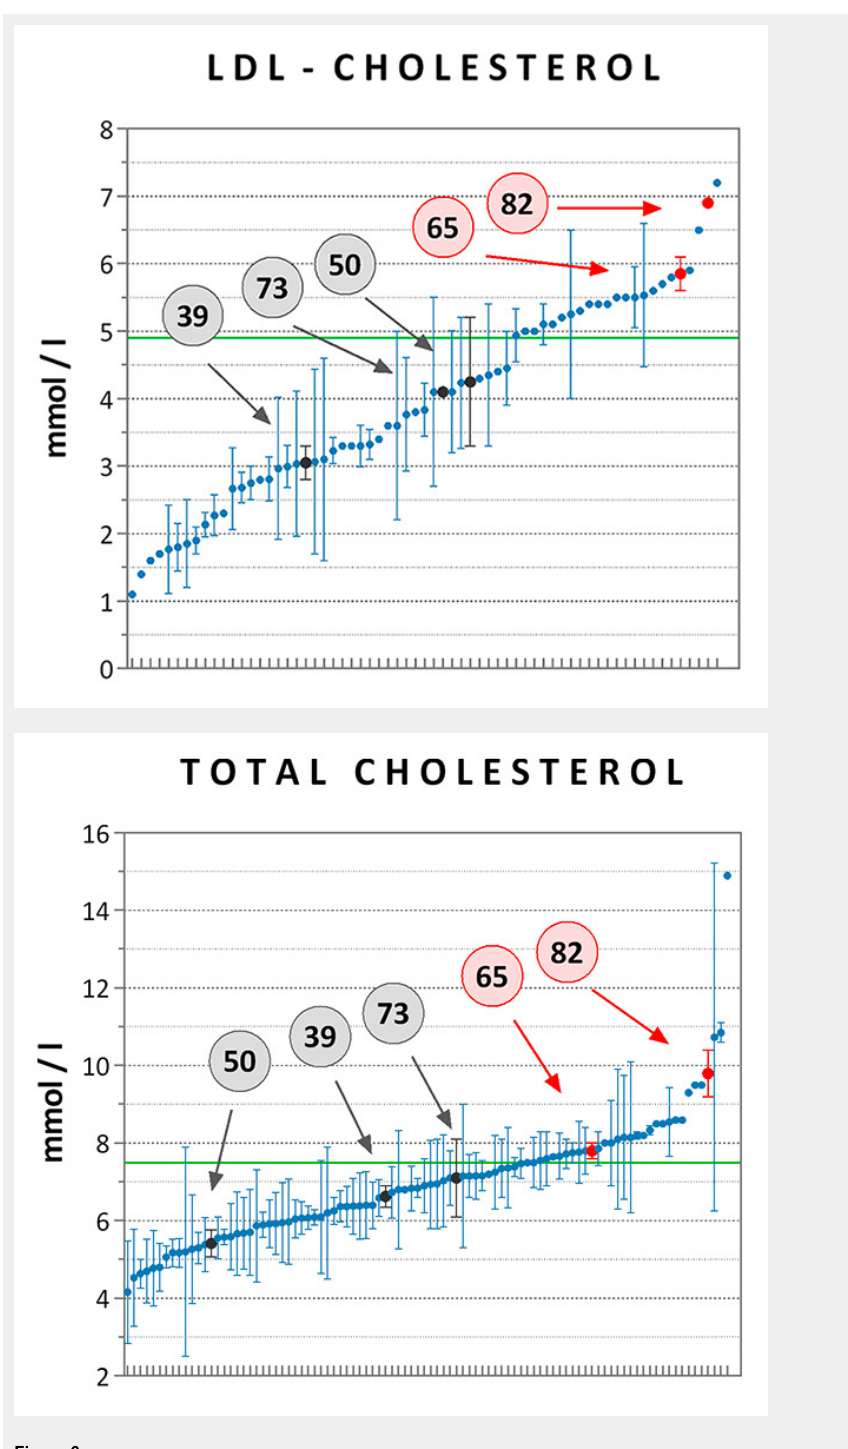
Figure 6 Cholesterol levels measured in carriers vs non carriers of rare, missense APOB and LDLR variants. Average LDL-C ( panel A ) and TC ( panel B ) levels were computed for each of the high-cholesterol patients tested by sequencing, irrespective of treatment. At least one value of LDL-C was available for 65 of the 94 subjects [n = 2 ± 4 data points per patient (mean ± SD)], while TC was measured at least once in all of them [n = 5 ± 6 data points per patient (mean ± SD)]. Data are presented as means ± standard error of the mean and are ranked from the lowest to the highest mean value. Data points referring to the carriers of pathogenic (patient #82) or likely pathogenic (patient #65) variants for FH are highlighted in red, while those referring to carriers of rare variants of unknown significance are highlighted in dark grey (patients #39, 73, and 50). The clinical thresholds of high LDL-C (4.9 mM) and TC (7.5 mM) are indicated by the green lines. FH = familial hypercholesterolaemia; LDL-C = low-density lipoprotein cholesterol; TC = total